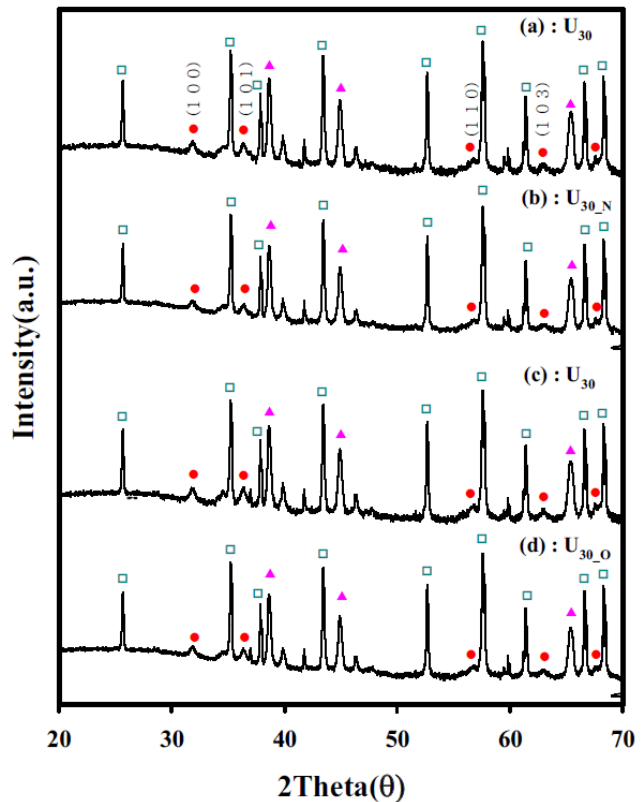
Figure 6. Comparison of XRD patterns of the original and additionally heat-treated sensors (